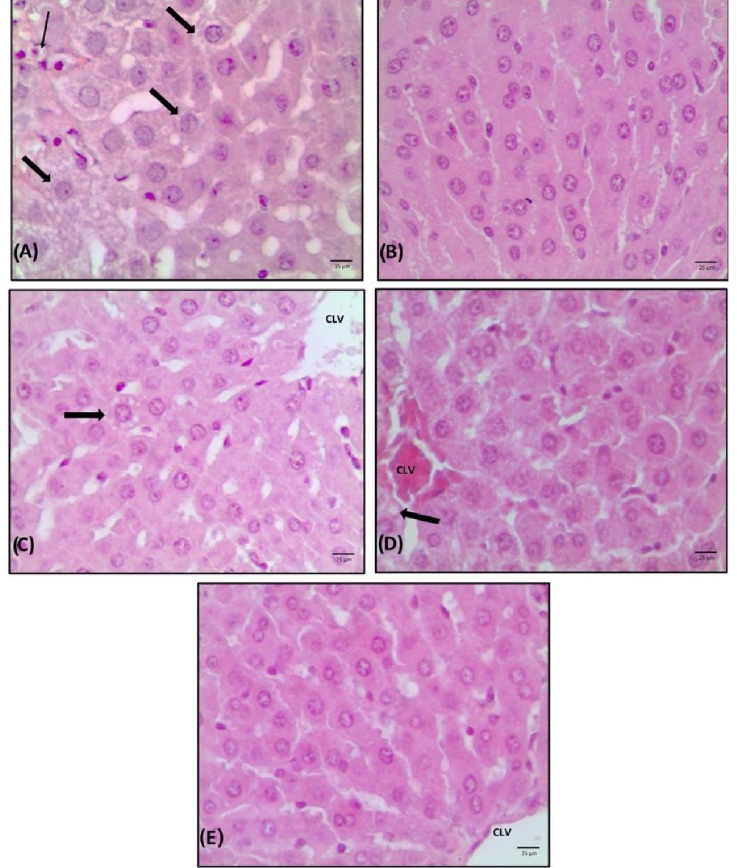
Figure 5. Liver photomicroscopy with haematoxylin-eosin (HE) staining. Increase 20× of animals treated with saline ( A ), estrogen ( B ), flaxseed extract ( C ), mulberry extract ( D ) and flaxseed + mulberry ( E ). The thin arrow indicates inflammatory infiltrate, and the thick arrow indicates steatosis. PS: portal space. CLV: central lobular vein. Table 2. Results of the histopathological analyses of the liver of animals treated with saline, estro- gen, flaxseed, mulberry, and flaxseed + mulberry extract. Adapted from [1] Kleiner et al. (2005). Table 3. Results of the histopathological analyses of the kidneys of animals treated with saline, estrogen, flaxseed, mulberry, and flaxseed + mulberry extract. Adapted from Yarijani et al.